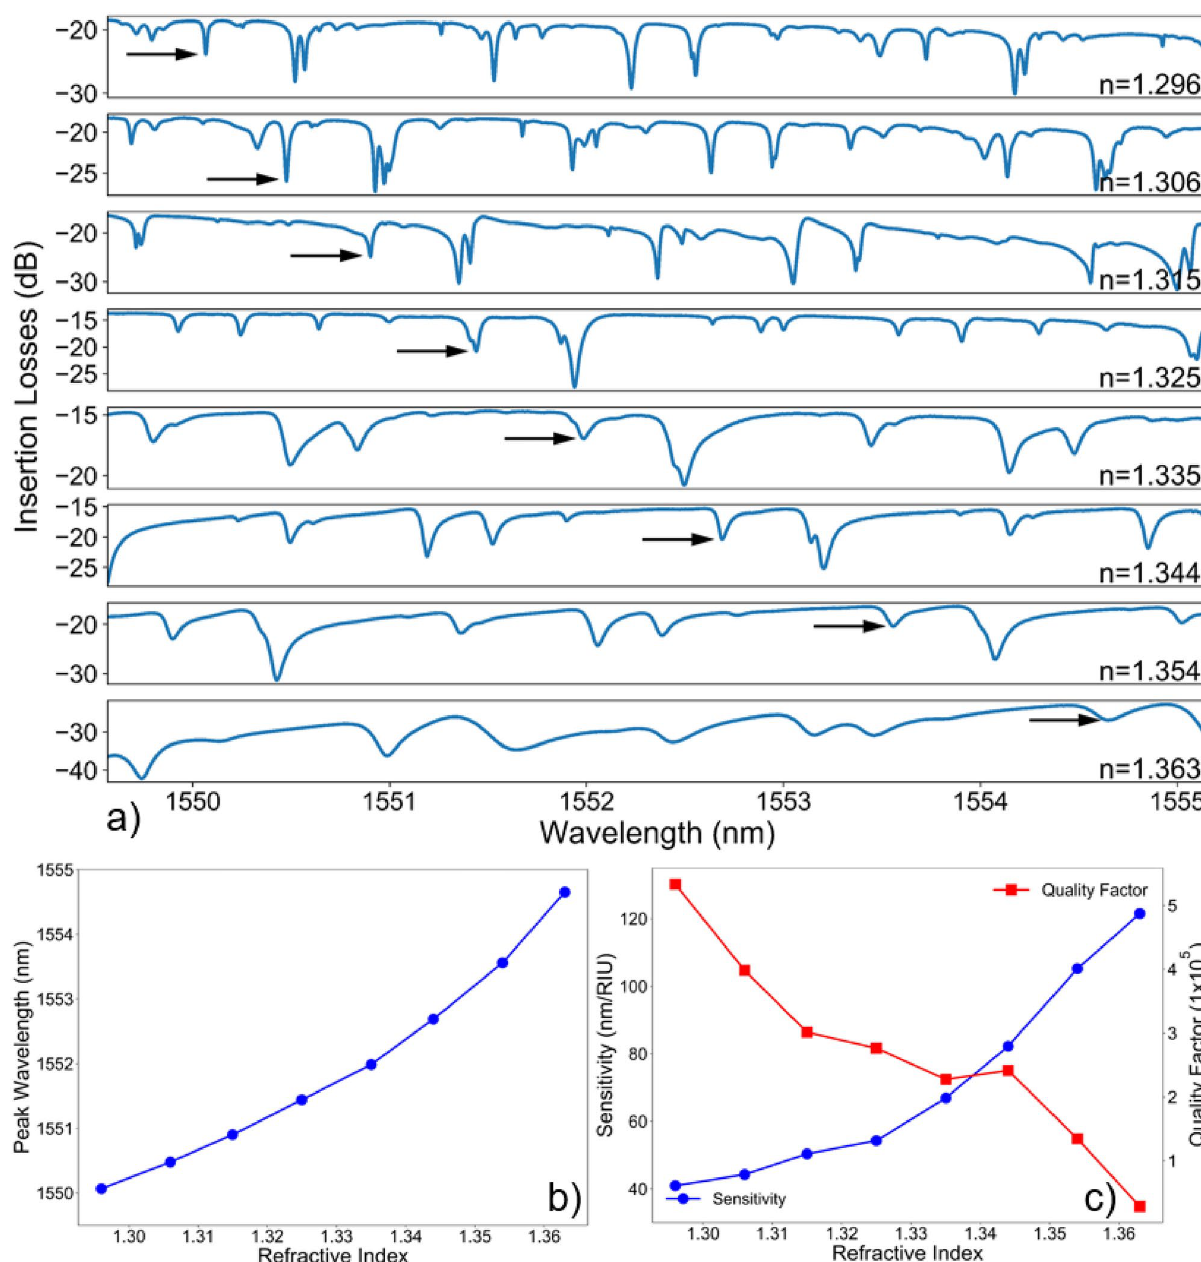
Figure 6. Optical characterization against refractive index. ( a ) Transmission spectrum of the suspended waveguide, described in Fig. 5c–d, against different fluids surrounding the microresonator. The arrow signals the WGM mode under analysis. ( b ) Evolution of the resonant wavelength with the external refractive index. ( c ) Sensitivity (circular markings) and Q-factor (square markings) against the surrounding